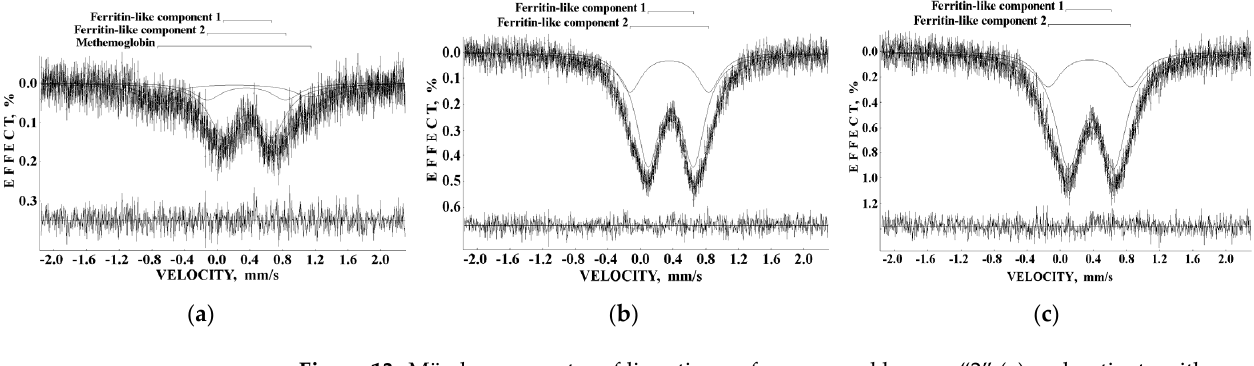
Figure 13. Mössbauer spectra of liver tissues from normal human “2” ( a ) and patients with mantle cell lymphoma “N” ( b ) and acute myeloid leukemia “Ch” ( c ) fitted within the simple heterogeneous model for the ferritin‑like iron cores (doublets 1 and 2) and component 3 for residual methemoglobin. The differential spectra are shown on the bottom. Adapted from Ref. [59] with permission from Springer Nature: Cell Biochemistry and Biophysics, “The iron state in spleen and liver tissues from patients with hematological malignancies studied using magnetization measurements and Mössbauer spectroscopy”, Alenkina I.V., Vinogradov A.V., Felner I., Konstantinova T.S.,